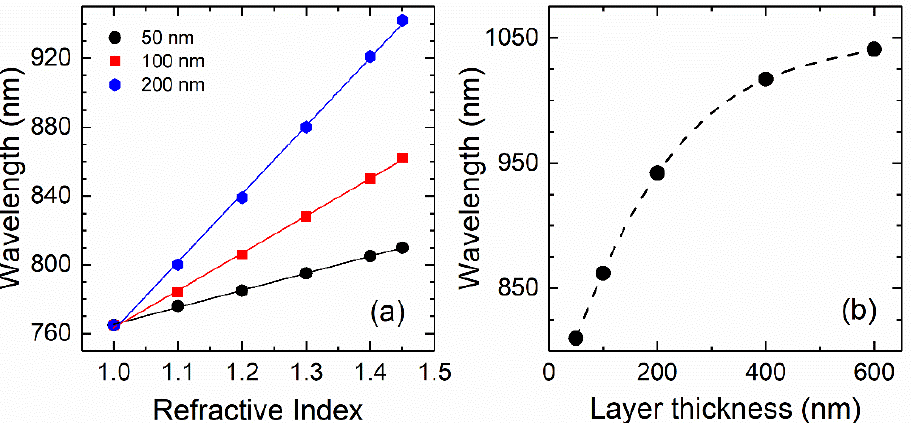
Figure 5. ( a ) Wavelength of the peak corresponding to the SLR at the test layer–Au interface as a function of the refractive index for three values of the test layer thickness, namely, 50, 100, and 200 nm. ( b ) Wavelength of the SLR peak corresponding to the test layer–Au interface for 𝑛 = 1.45 as a function of the layer thickness. The dashed line is only a guide to the eye.